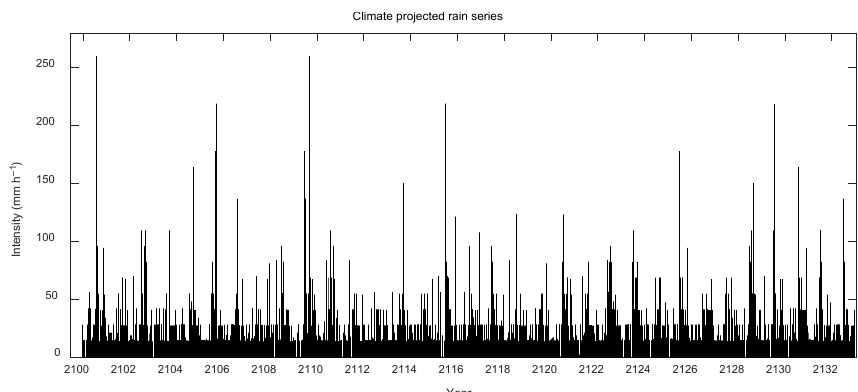
Figure 7. Time series example of climate-projected rainfall series. The temporal resolution of rainfall data is